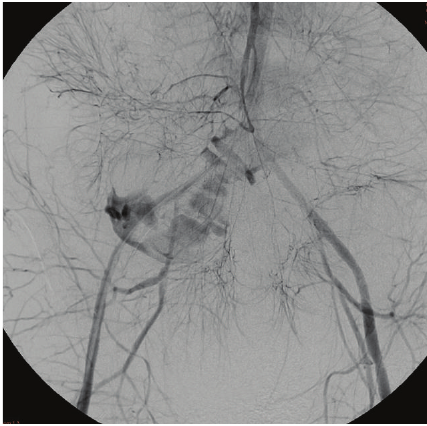
Figure 2: Superior mesenteric arteriogram (with injector device) demonstrates arteriojejunal fistula via the right external iliac artery.